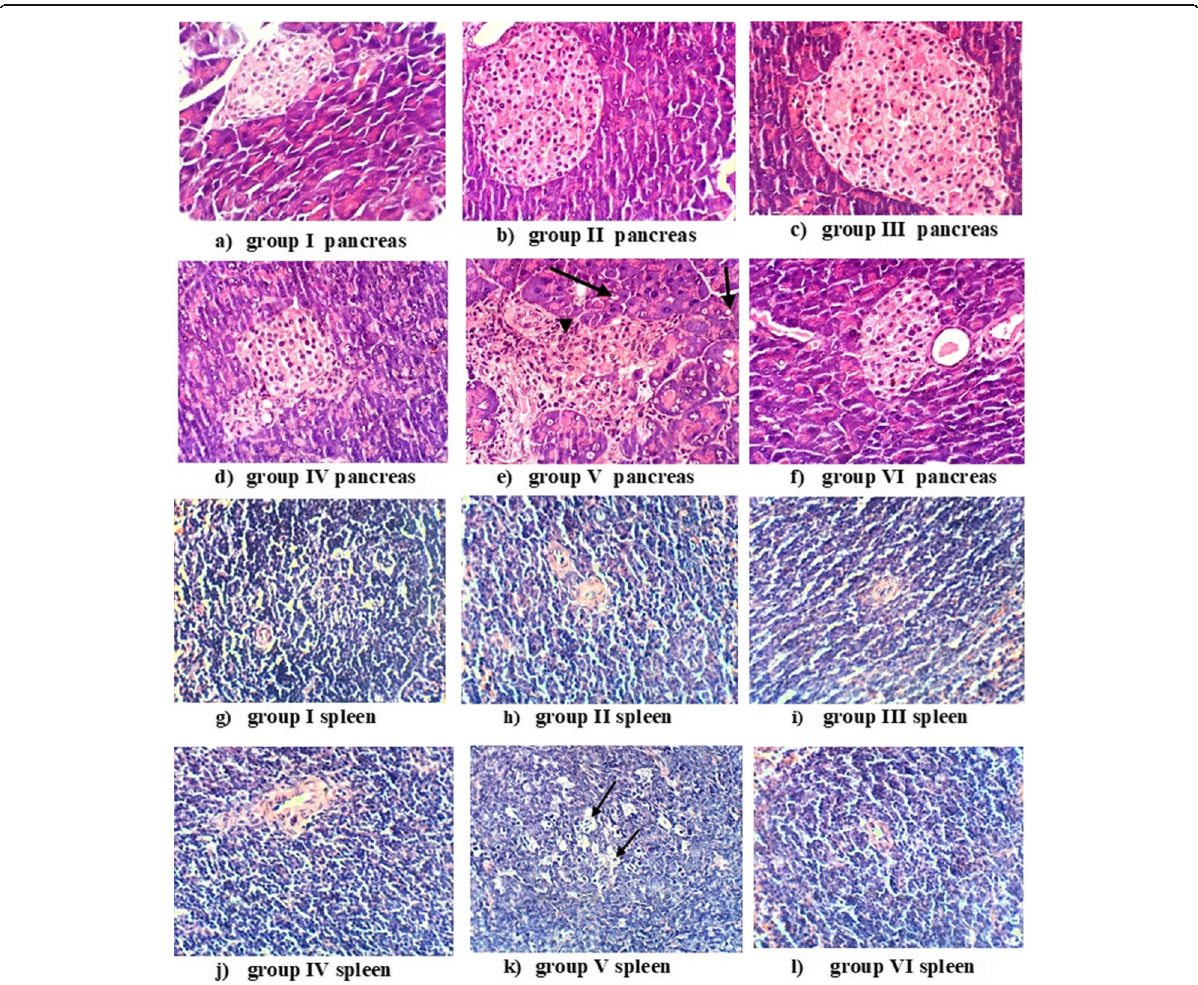
Fig. 1 Histological evaluation of pancreatic islets ( a – f ) and spleen tissues ( g - l ) stained with hematoxylin and eosin dyes, × 400 magnification. Pancreatic sections showed the following: a – d normal appearance of islets; e vacuolation of cells in pancreatic acini (small arrow), apoptosis of acinar epithelium (large arrow), and mononuclear inflammatory cells infiltration (arrowhead); f regular outline with normal appearance. Spleen sections showed the following: g – j normal appearance of lymphoid follicles; k lymphocytic necrosis and depletion in the splenic lymphoid follicle (arrow); l normal appearance of splenic lymphoid follicles. I, normal mice; II, mice treated with citrate; III, mice treated with DMSO; IV, mice treated with curcumin at a dose of 170 mg/kg trice a week; V, diabetic mice induced by injection with 160 mg/kg of STZ; and VI, diabetic mice